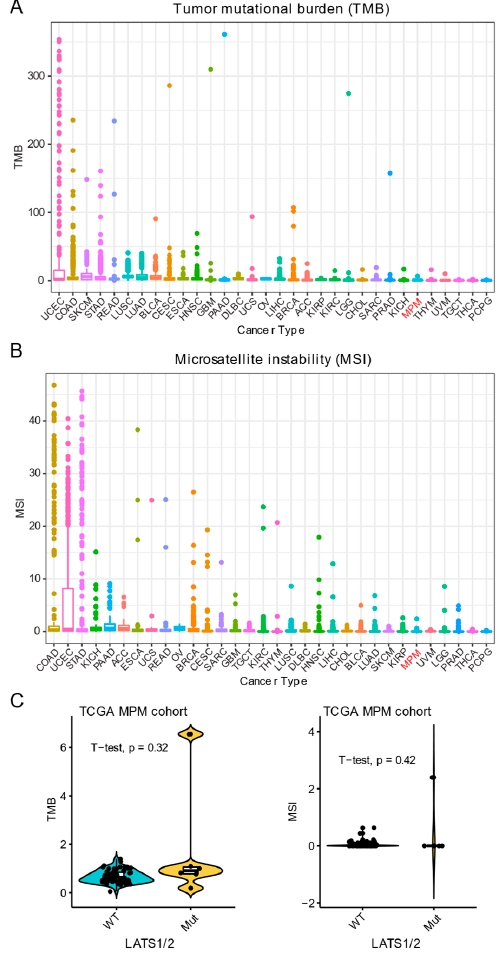
Figure 5. Association of LATS1/2 mutations with TMB and MSI in MPM. ( A , B ) Tumor mutational burden (TMB; A ) and microsatellite instability (MSI; B ) across TCGA pan ‐ cancer cohort. ( C ) Association of LATS1/2 mutations with TMB and MSI in MPM.